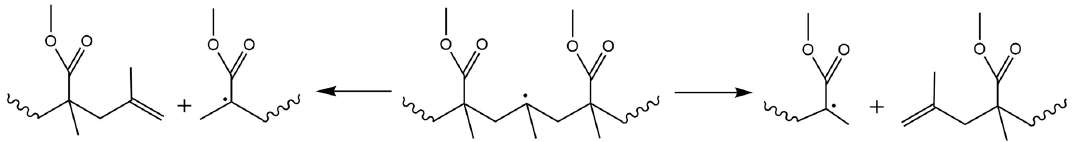
Figure 14. β -scission of the mid-chain radical formed during side-group fission (“second” type of β -scission); shown is a β -scission to the “left” and the “right”.